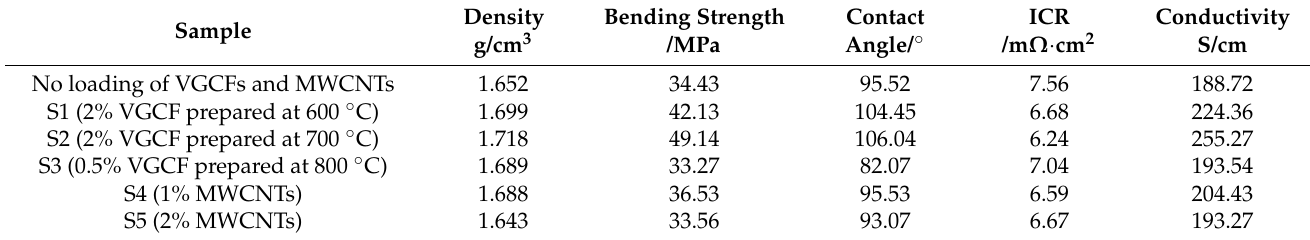
Table 3. Comprehensive performance comparison of BPs.